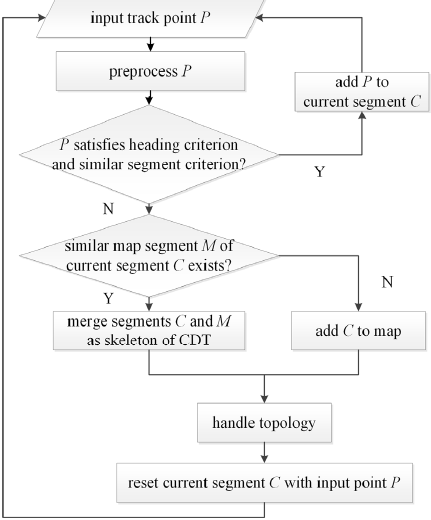
Figure 1. Flowchart of the proposed road map construction method. CDT, constrained Delaunay triangulation.